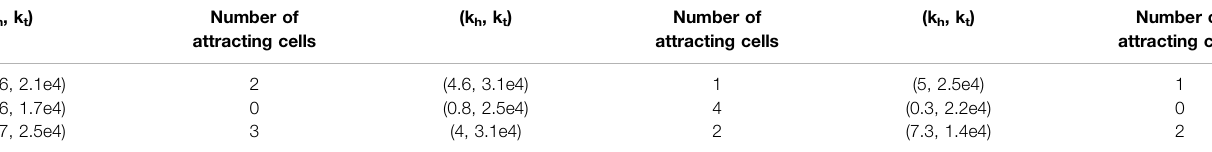
TABLE 1 | The number of attractive cells obtained by searching under typical stiffness ratios. (k h , k t